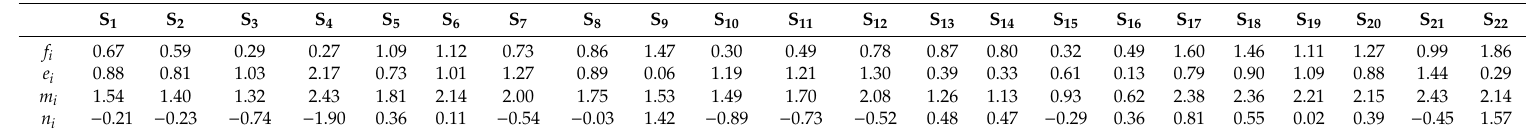
Table 4. Results of influencing and influenced degrees, centrality and causality.